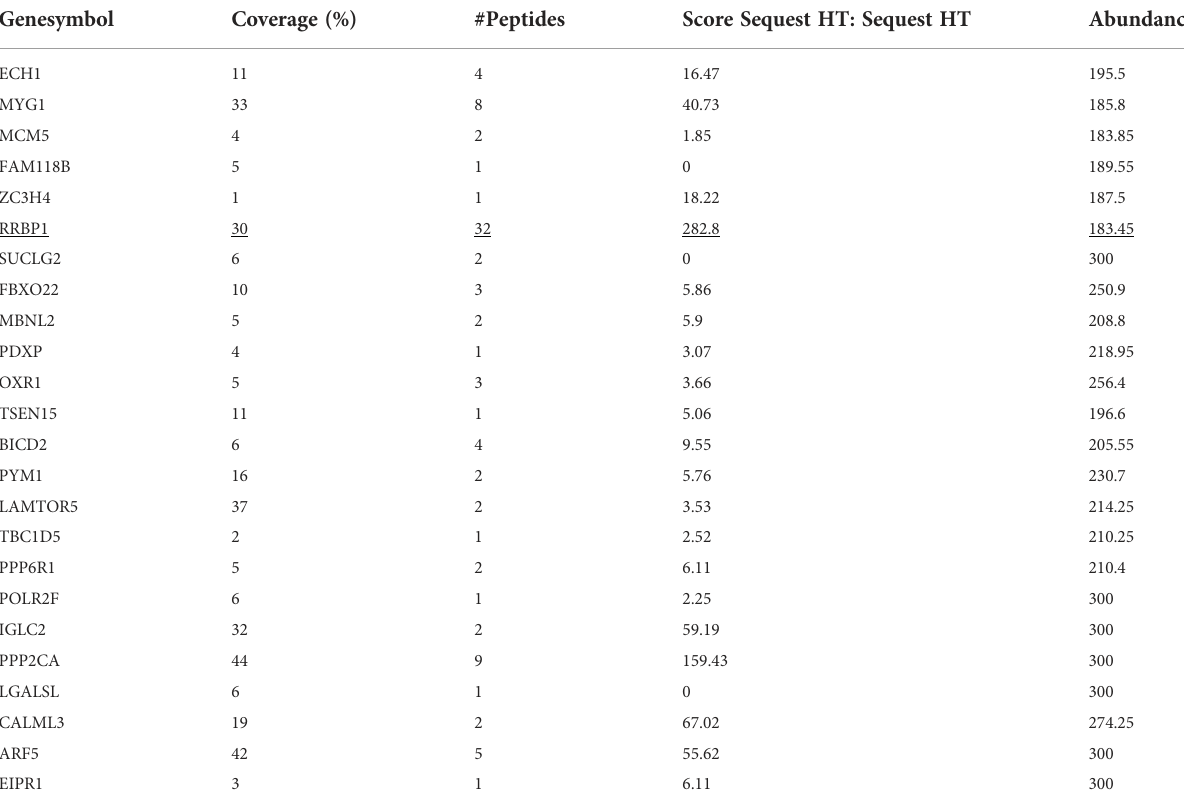
TABLE 5 Abundances of 24 types of shared proteins in CM -231 and CM-PC3.